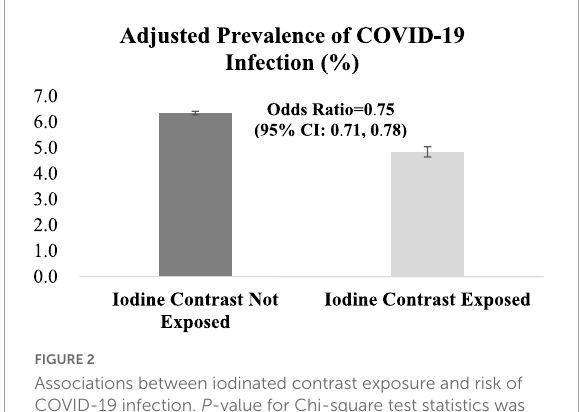
FIGURE2 Associations between iodinated contrast exposure and risk of COVID-19 infection. P -value for Chi-square test statistics was <